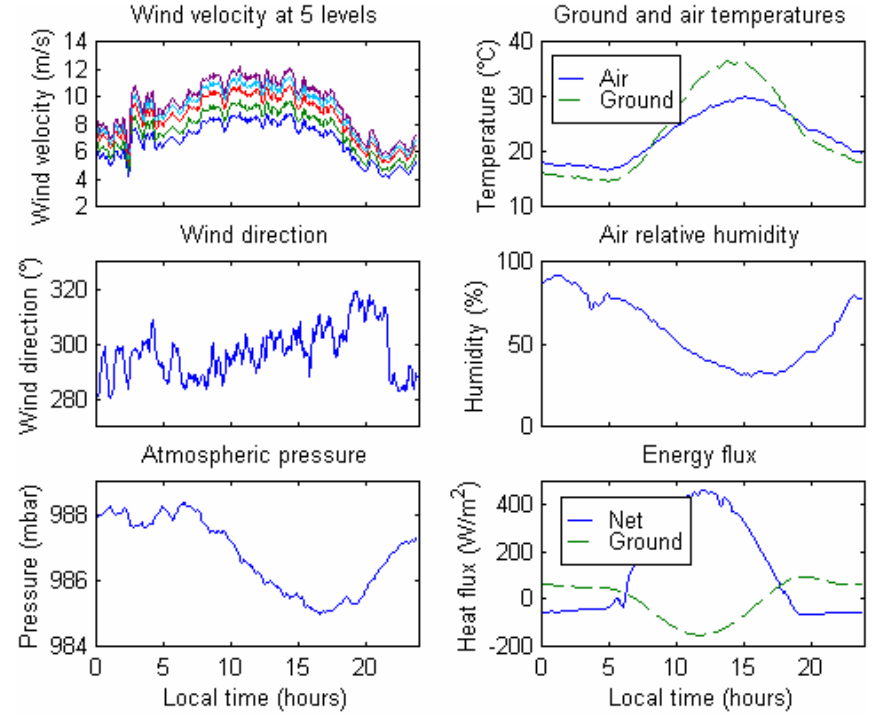
Figure 2: Micro meteorological parameters measured during the experiment (Plot CT, 25 July 1997)